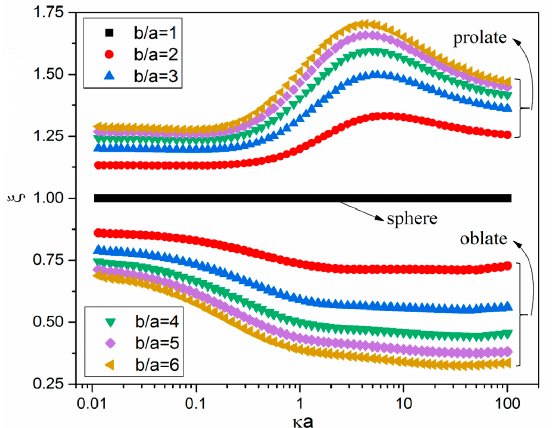
D D ξ on a κ for six differ- on κ a for six different S T T S